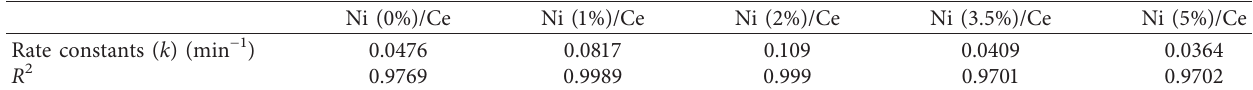
Figure 9: Electrochemical decolorization performance at Ti/SnO 2 -Sb-Ni/Ce electrodes modified with various Ni contents. (a) Decol- orization efficiency. (b) Kinetic analysis of the curves (RhB concentration: 20mg · L − 1 ; current density: 10mA · cm − 2 ; supporting electrolyte: 0.1mol · L − 1 Na 2 SO 4 ; 25 ° C). Table 4: Kinetic parameters of 20mg · L − 1 RhB in electrochemical processes by Ti/SnO 2 -Sb-Ni/Ce electrodes modified with various